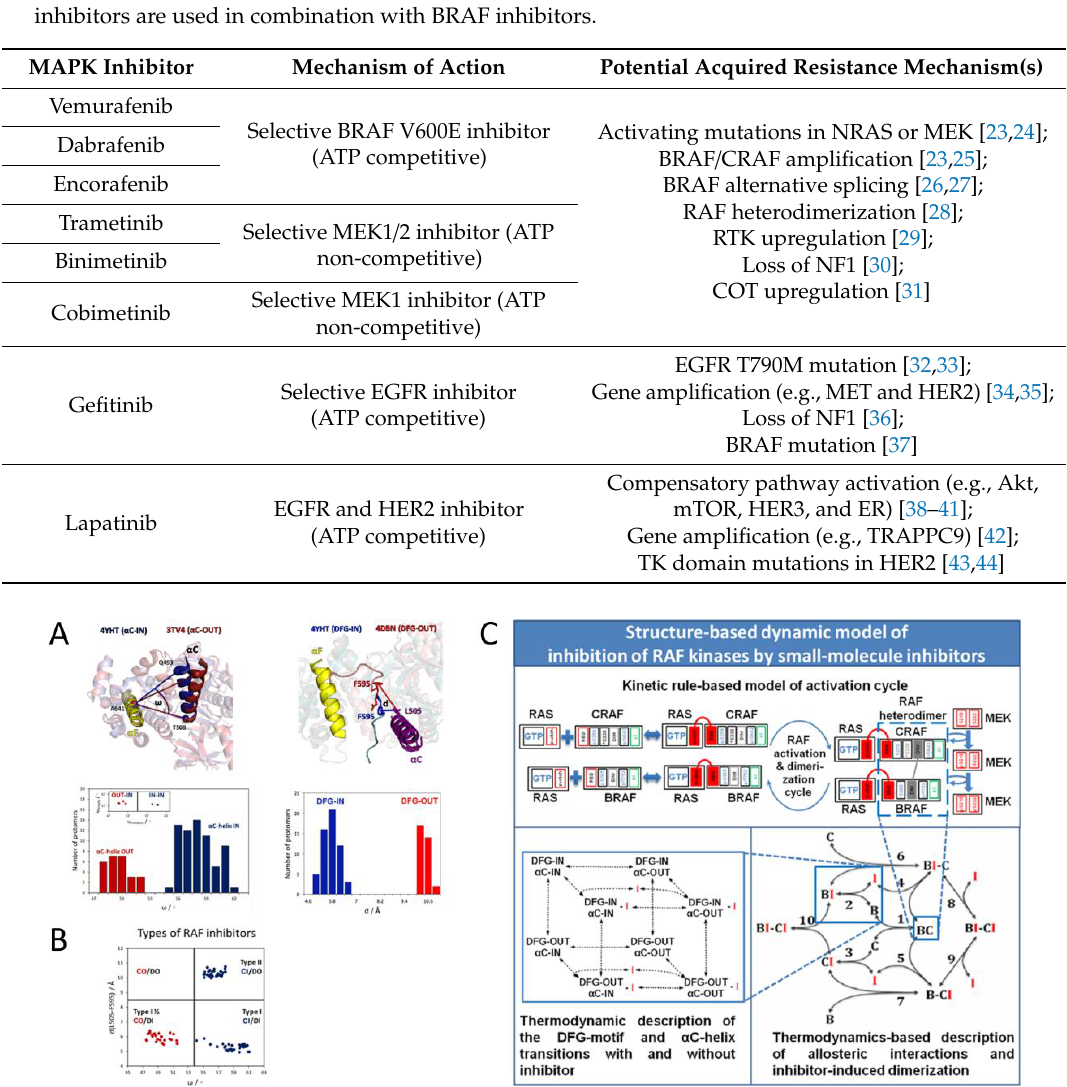
Figure 4. Targeting RAF dimerization. ( A ) X-ray structures showing the two conformations (in / out) of the C α helix and DFG motif and their distribution in available RAF structures deposited in the Protein Data Bank. ( B ) Frequency of in / out distributions and RAF inhibitors targeting such conformations. ( C ) Depiction of the computational modeling approach developed by Rukhlenko et al.